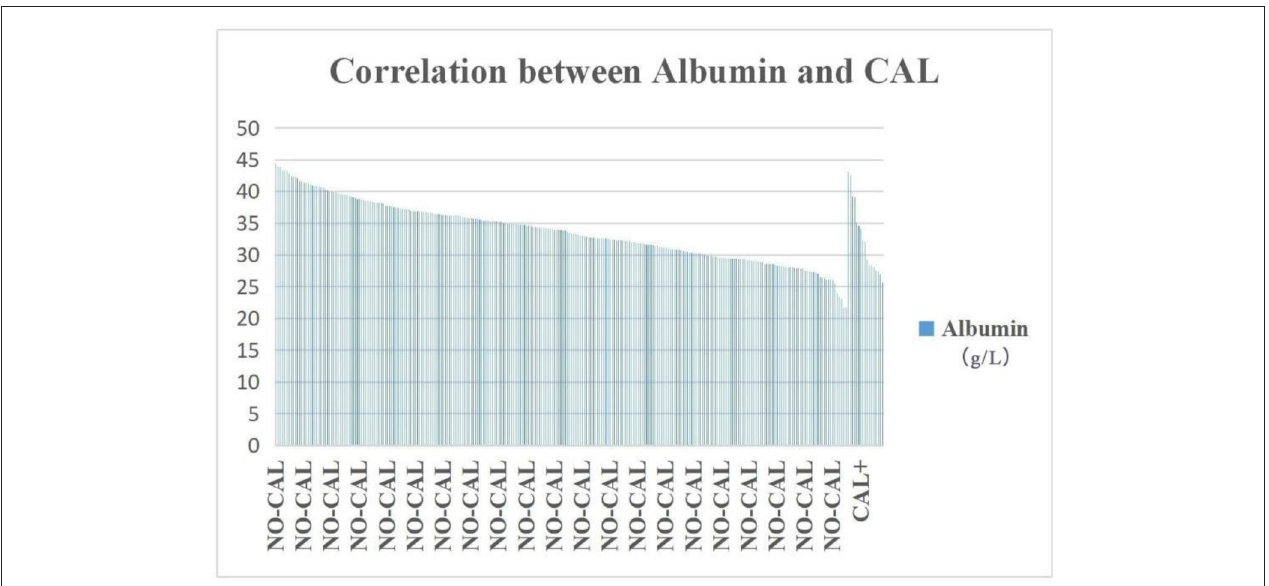
FIGURE 2 | The incidence of hypoproteinemia was significantly higher in the CAL group than in the NO-CAL group ( p < 0.05). The X-axis indicates with or without presence of CAL. The Y-axis represents the albumin (g/L).